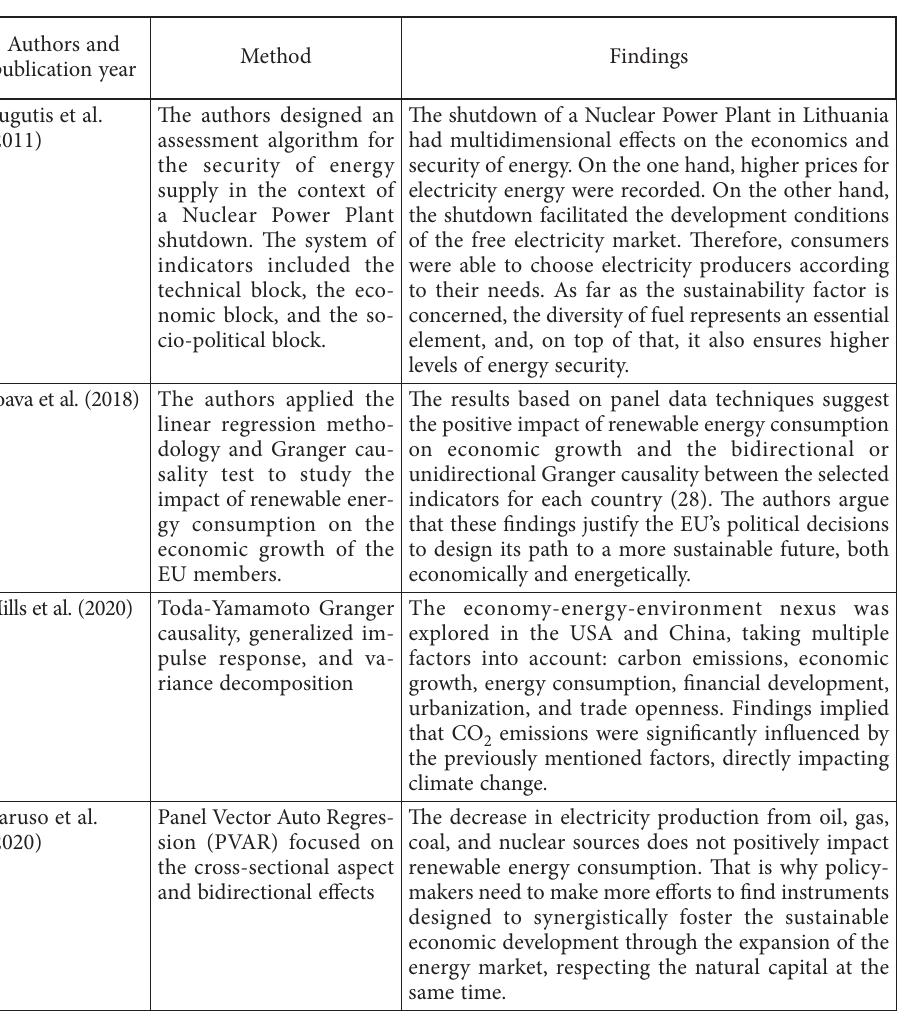
Table 1. Examples of transition patterns (source: authors’